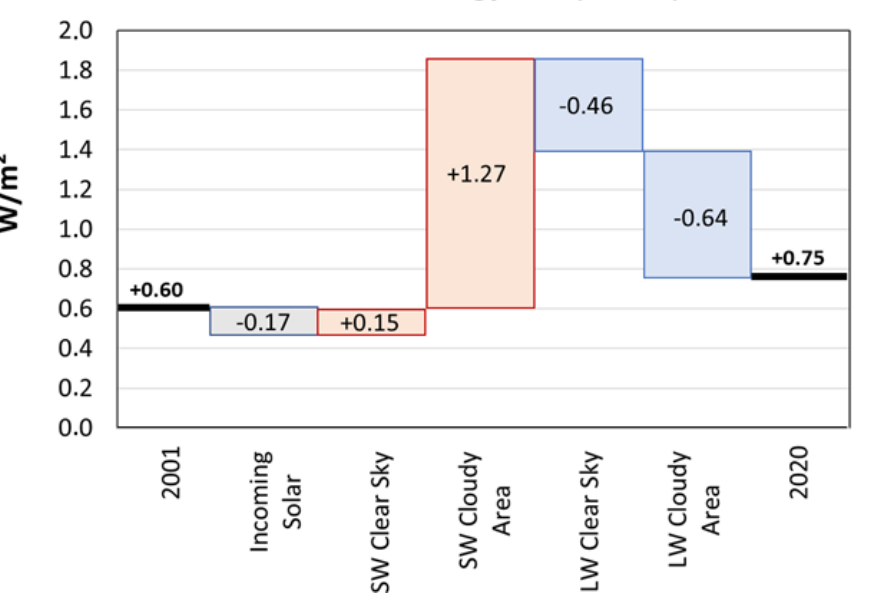
Figure 15. Bridge-chart for the actual changes at TOA from 2001 to 2020 (“start-to-end change”), dominated by the change in the outgoing shortwave radiation over “Cloudy Areas”. The declining SW (out) is the major heating cause. It is almost compensated by the chilling LW (out). The incremental effects are weighted by area (see the example in the caption of Figure 16).